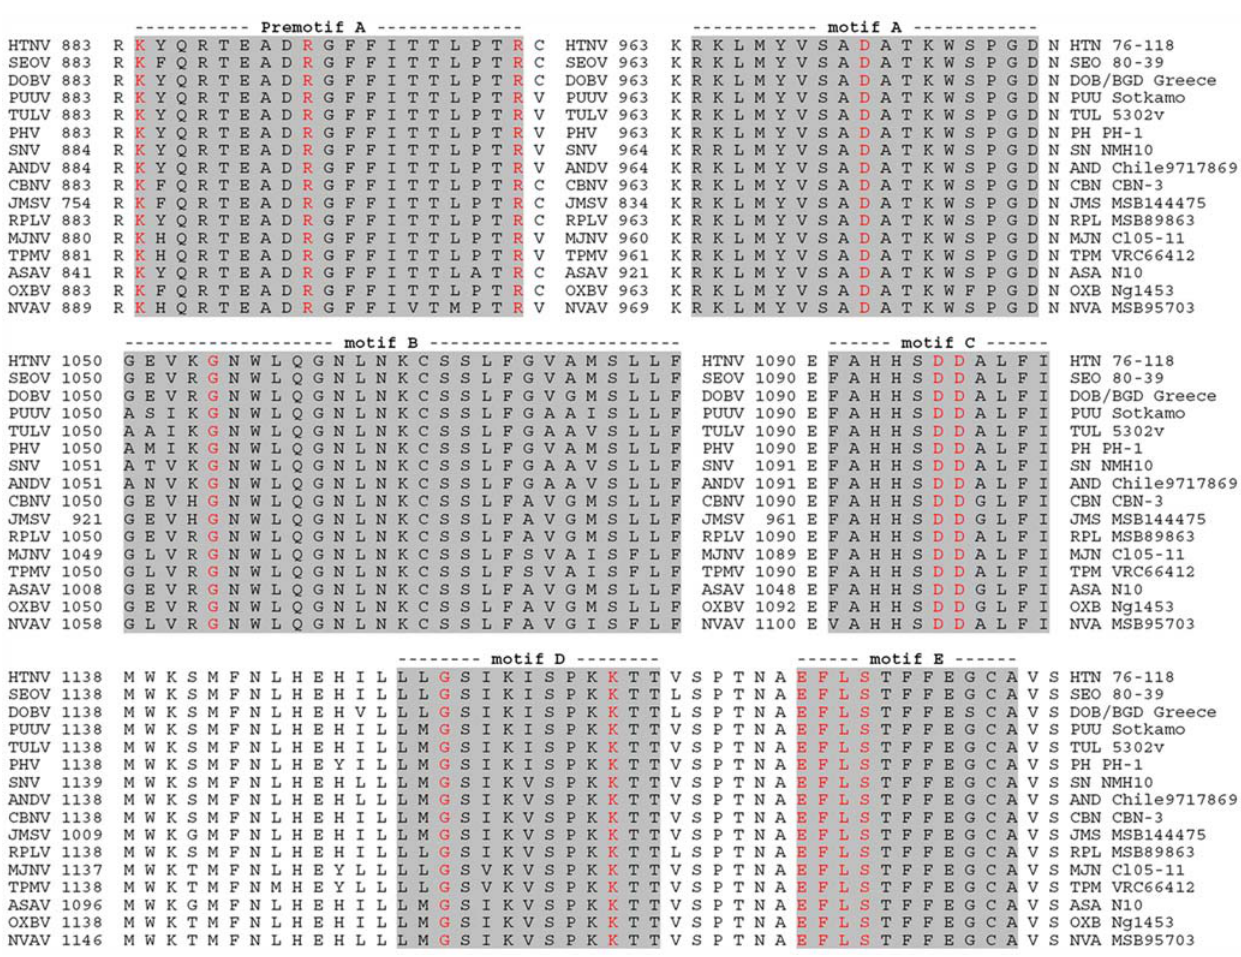
Figure 2. L-segment amino acid sequence alignment of the region spanning the premotif A and motifs A–E in hantaviruses. Highly conserved amino acids are highlighted in red and only presented in polymerases of negative stranded RNA viruses. A multiple amino acid sequence alignment of RNA-dependent RNA polymerases was created using the ClustalW method for the following hantaviruses: Hantaan virus (HTN 76–118, NC_005222), Dobrava/Belgrade virus (DOB/BGD Greece, NC_005235), Seoul virus (SEO 80–39, NC_005238), Tula virus (TUL 5302v, NC_005226), Puumala virus (PUU Sotkamo, NC_005225), Prospect Hill virus (PH PH-1, EF646763), Sin Nombre virus (SN NMH10, NC_005217), Andes virus (AND Chile9717869, AF291704), Thottapalayam virus (TPM VRC66412, EU001330), Imjin virus (MJN Cl05–11, EF641806), Cao Bang virus (CBN CBN-3, EF543525), Jemez Springs virus (JMS MSB144475, FJ593501), Camp Ripley virus (RPL MSB89863, EF540771), Asama virus (ASA N10, EU929078), Oxbow virus (OXB Ng1453, FJ593497) and Nova virus (NVA MSB95703,